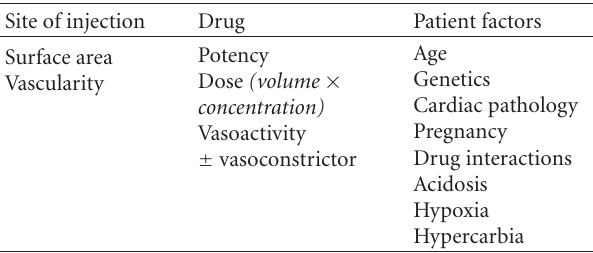
Table 2: Factors a ff ecting LA